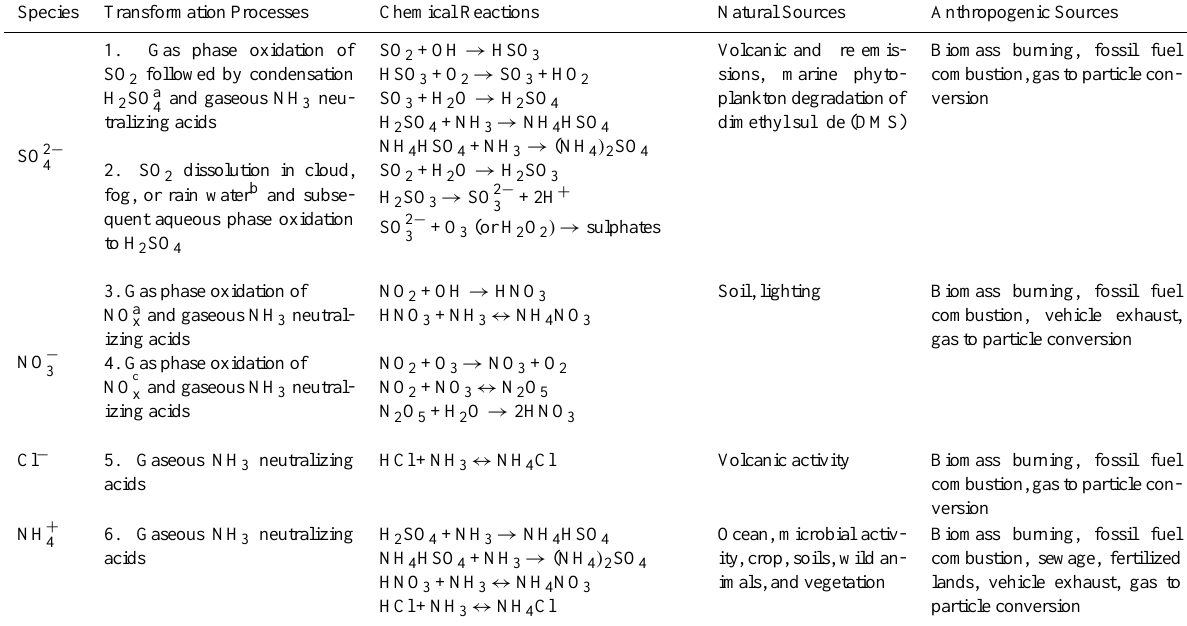
Table 1. Summary of the main natural and anthropogenic sources, and formation pathways for the major inorganic constituents of secondary PM 2 . 5 . a means “day”; b means “day and night”; c means